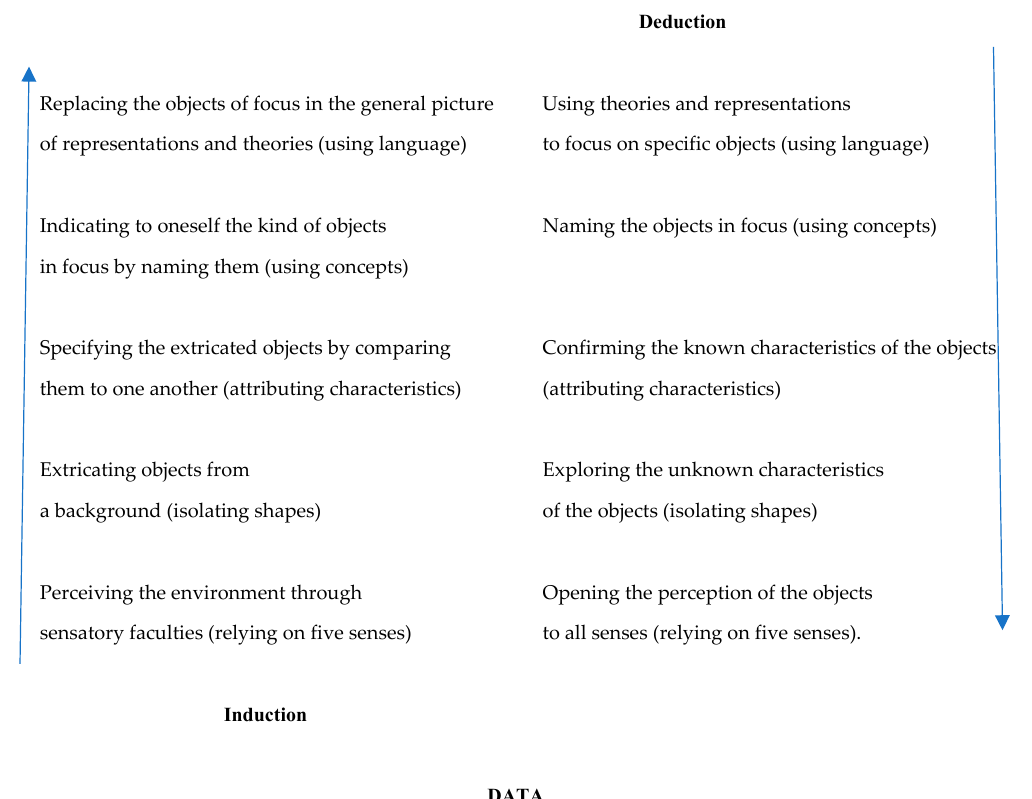
Figure 3. Inductive and deductive operations.